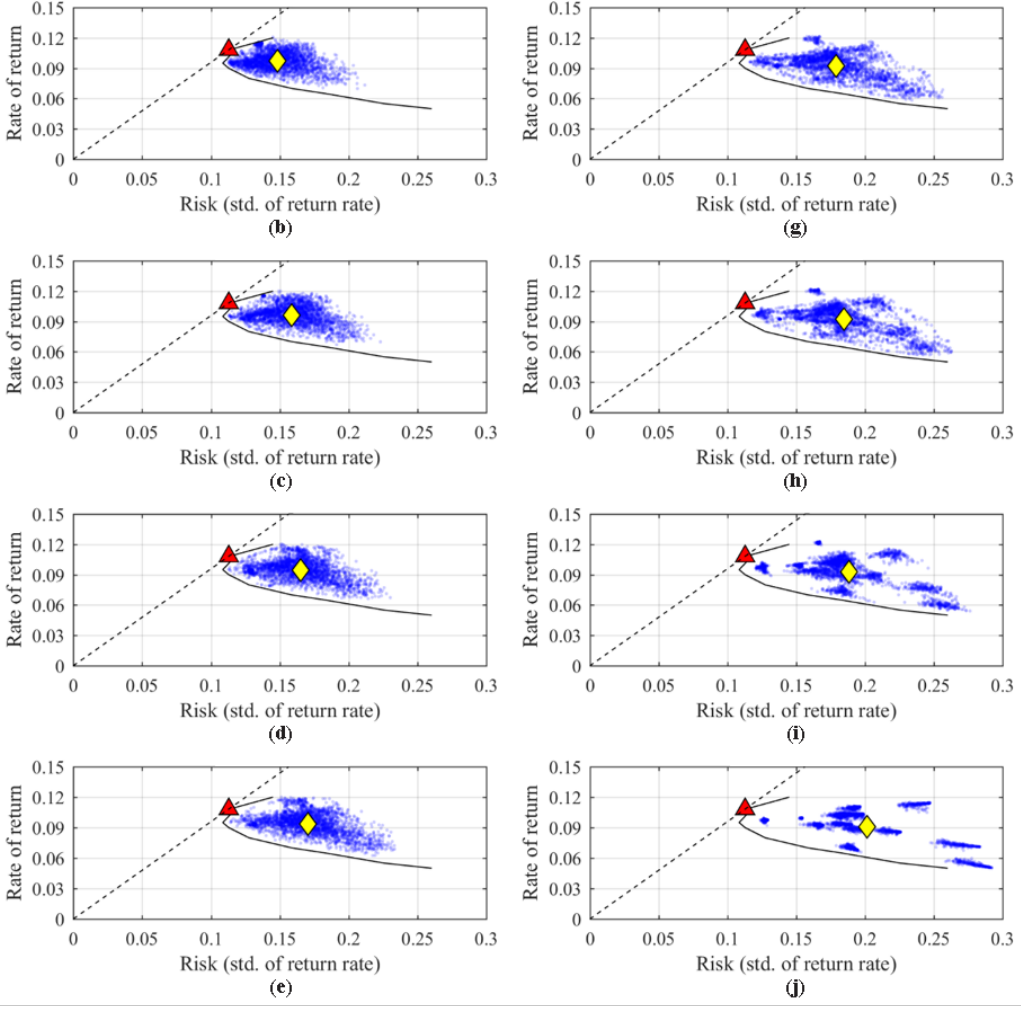
Figure 7. Risk-return graphs according to the Euclidean distance groups. ( a ) Group 1; ( b ) Group 2; ( c ) Group 3; ( d ) Group 4; ( e ) Group 5; ( f ) Group 6; ( g ) Group 7; ( h ) Group 8; ( i ) Group 9; ( j ) Group 10. Table 6. Summary statistics of the mean return and the risk according to the Euclidean distance groups. Average Standard Deviation Group Mean Return Risk Mean Return